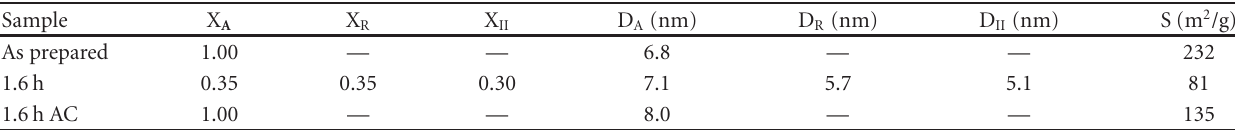
Table 1: Phase composition (X A fraction of anatase; X R , rutile; X II , TiO 2 -II phase), specific area (S) and crystal size (D A , anatase; D R , rutile and D II , TiO 2 -II phase) of the di ff erent phases present at the as prepared sample and after grinding for 1.6 hours without additives (1.6h) and with ammonium carbamate additive (1.6h AC),